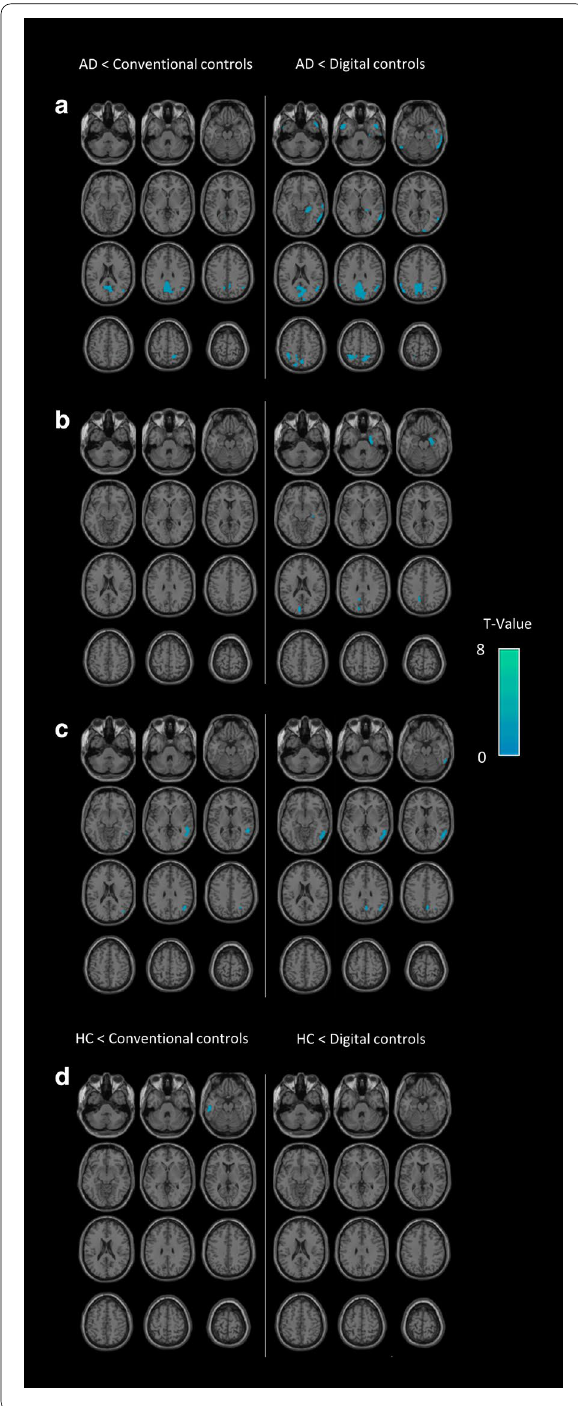
standpoint and at the individual level, this fully auto- mated analysis was nevertheless consistent with the visual analysis, using a methodology that is very simi- lar to that applied in previously published SQA stud- ies [6, 12]. By using this visual analysis, the diagnostic